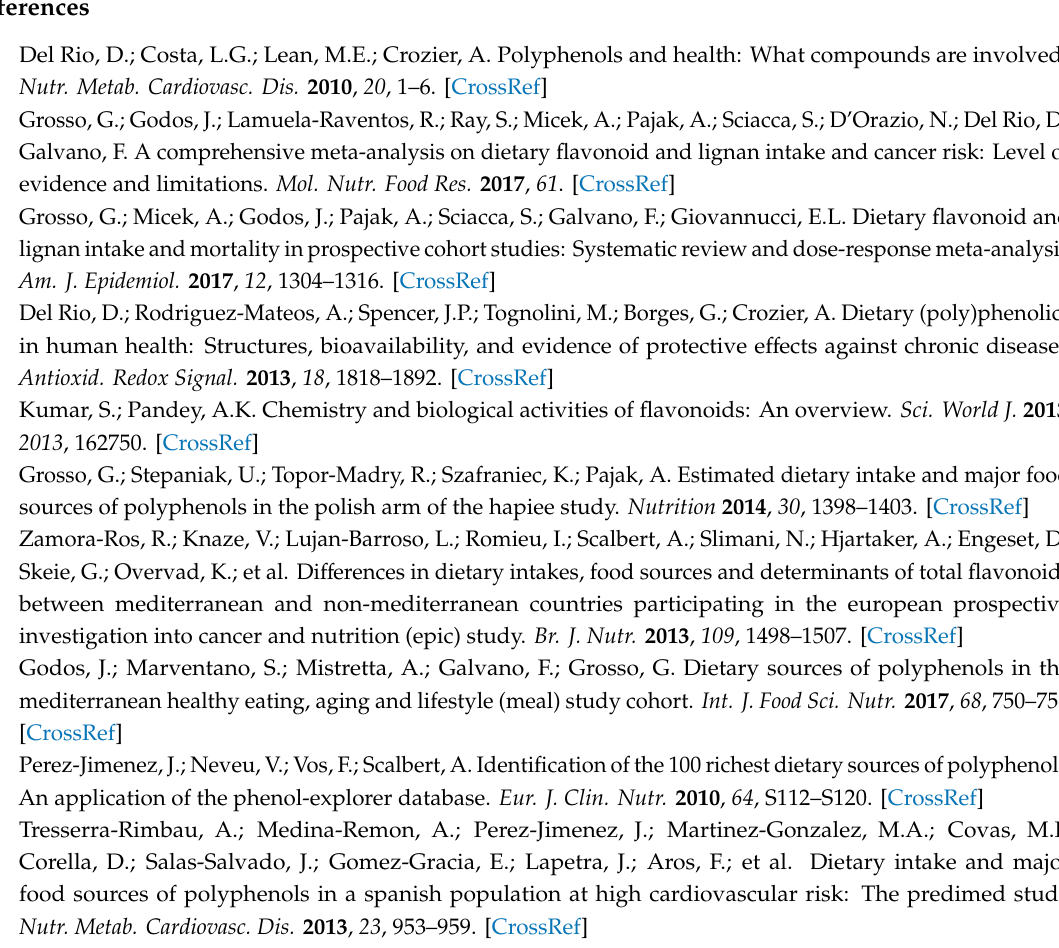
Figure S1: Funnel plot for hypertension risk of the highest versus lowest (reference) category of dietary flavonoid intake, Table S1: PRISMA